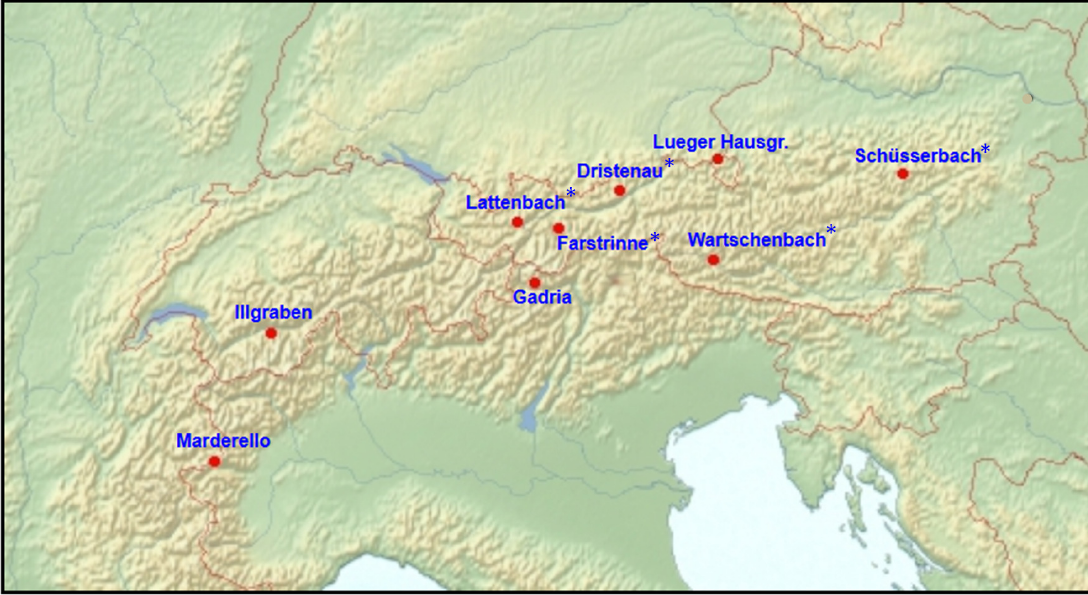
Figure 3. Overview of the test sites from 2013 to 2016 (* test sites already presented in